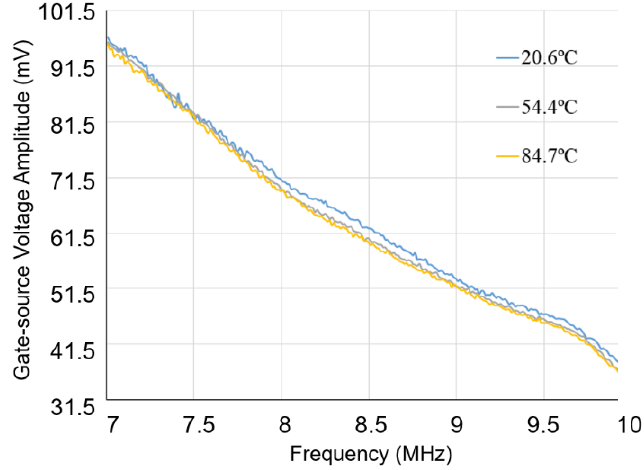
Figure 12. Gate-source voltage amplitude 𝑉 𝐺𝑆 at 300 V DC-link.